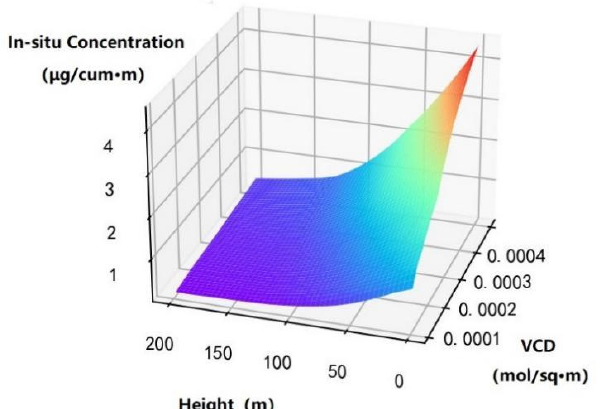
Figure 6. The model’s estimation of in-situ concentrations of HCHO at certain height and vertical column densities when altitude is fixed at 0 m.